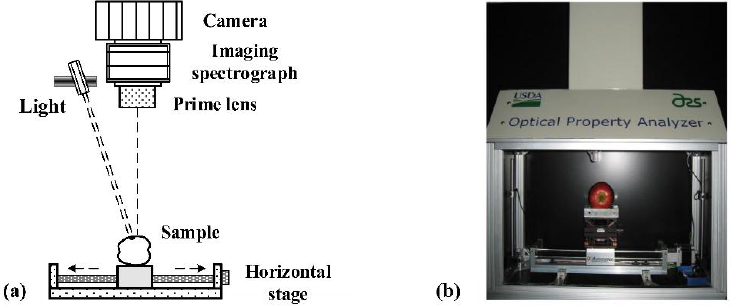
Figure 20. ( a ) Schematic and ( b ) photo of the hyperspectral imaging-based optical property analyzer (OPA).